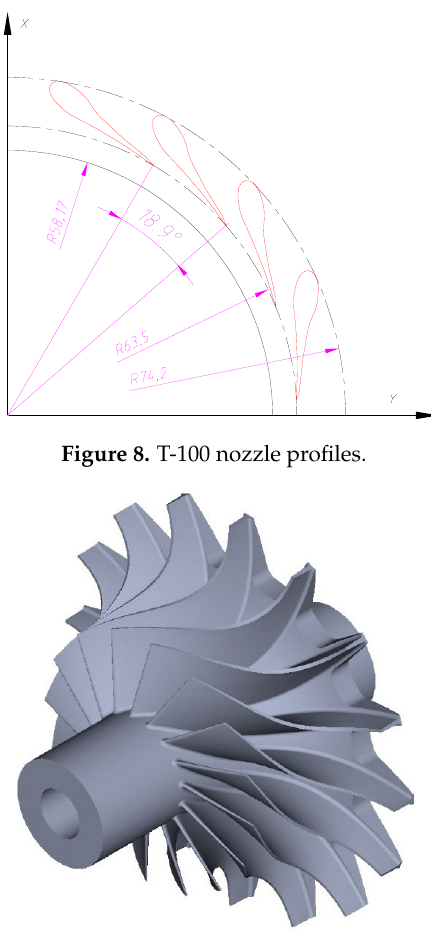
Figure 9. T-100 rotor geometry.